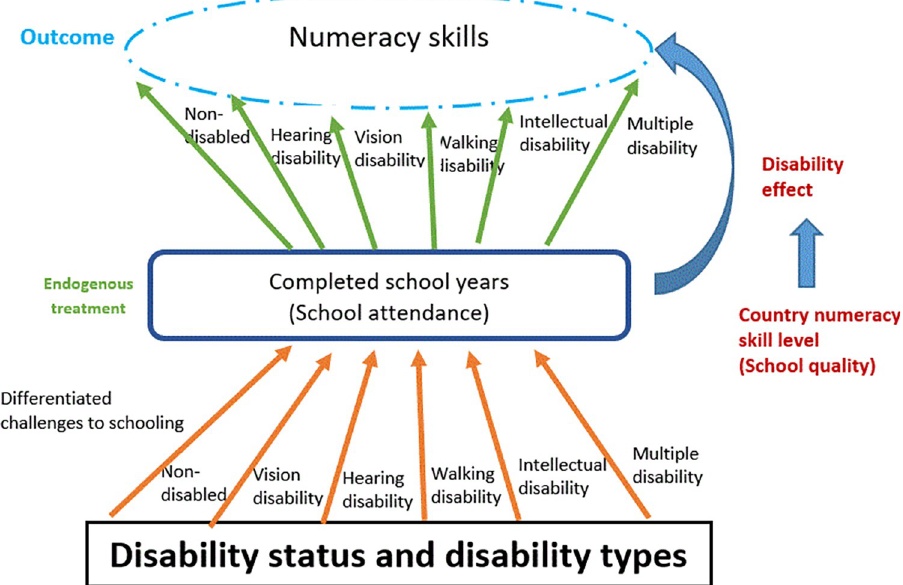
Fig 1. Framework on numeracy skills performance for children with and without